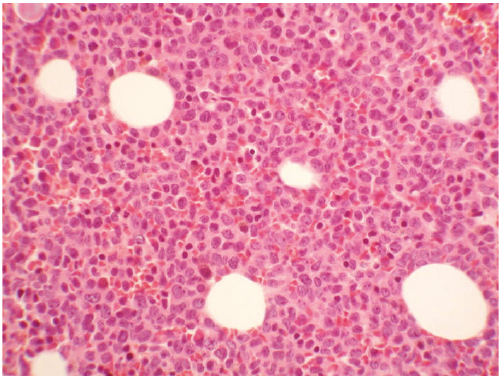
Figure 3: High power photomicrograph of bone marrow showing areas of necrosis and nonnecrotic areas after G-CSF